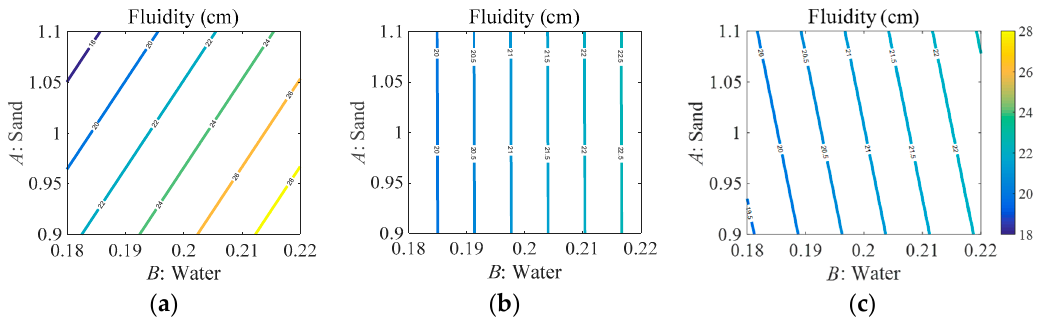
Figure 3. Contour plots of the s / b ratio ( A ) and w / b ratio ( B ) on fluidity. ( a ) D = 0.2; ( b ) D = 0.38 and ( c ) D = 0.4.